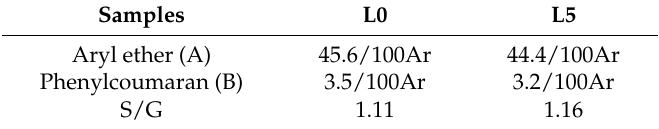
Table 5. Quantitative composition information of lignin samples (L0 and L5) from 2D HSQC NMR spectra.